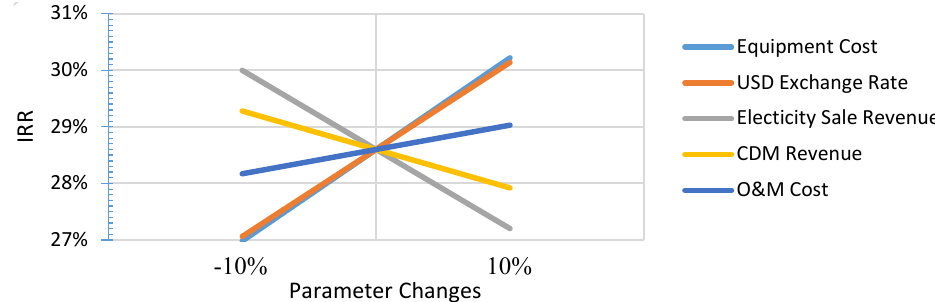
Fig. 1: Diagram of IRR sensitivity to variation of various parameters in the investment plans for power plants